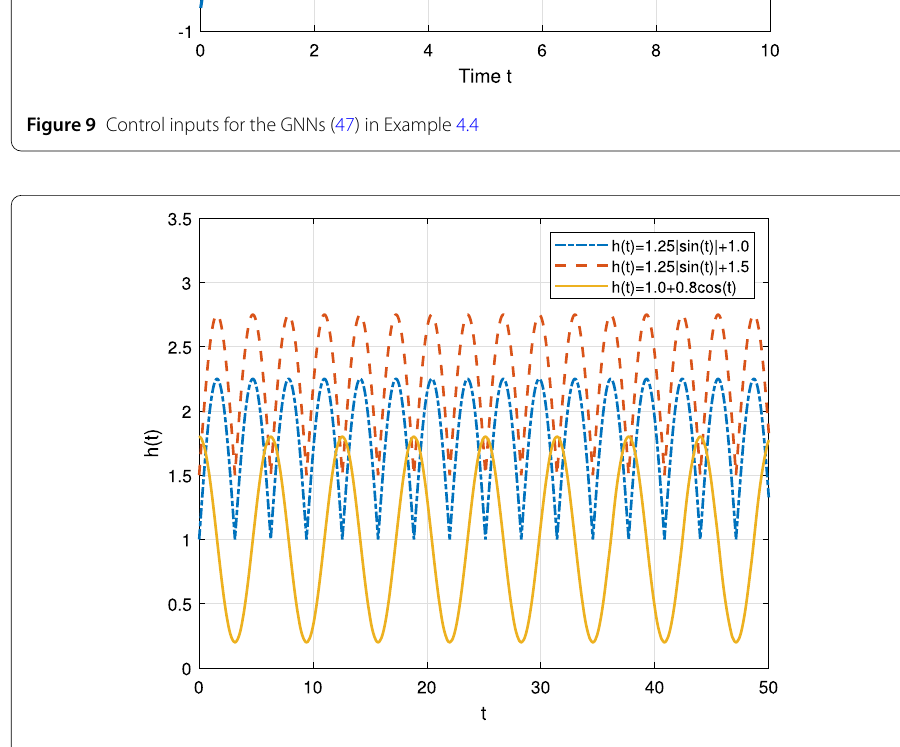
Figure 10 Continuous time-varying delay functions for t ∈ [0,50]